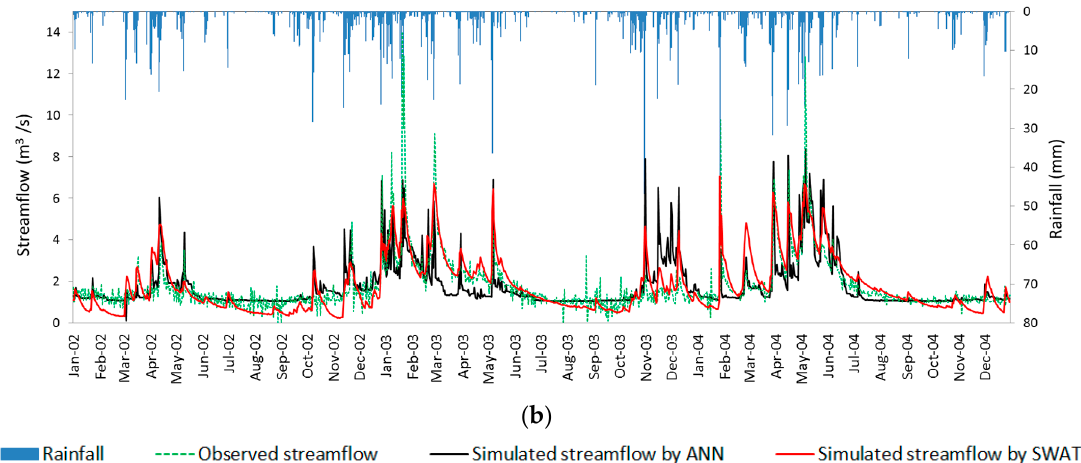
Figure 5. Comparison of observed and simulated daily streamflow by SWAT and ANN in validation phase, while the bar graph at the top is the daily precipitation for ( a ) LRB; ( b ) HSRB.